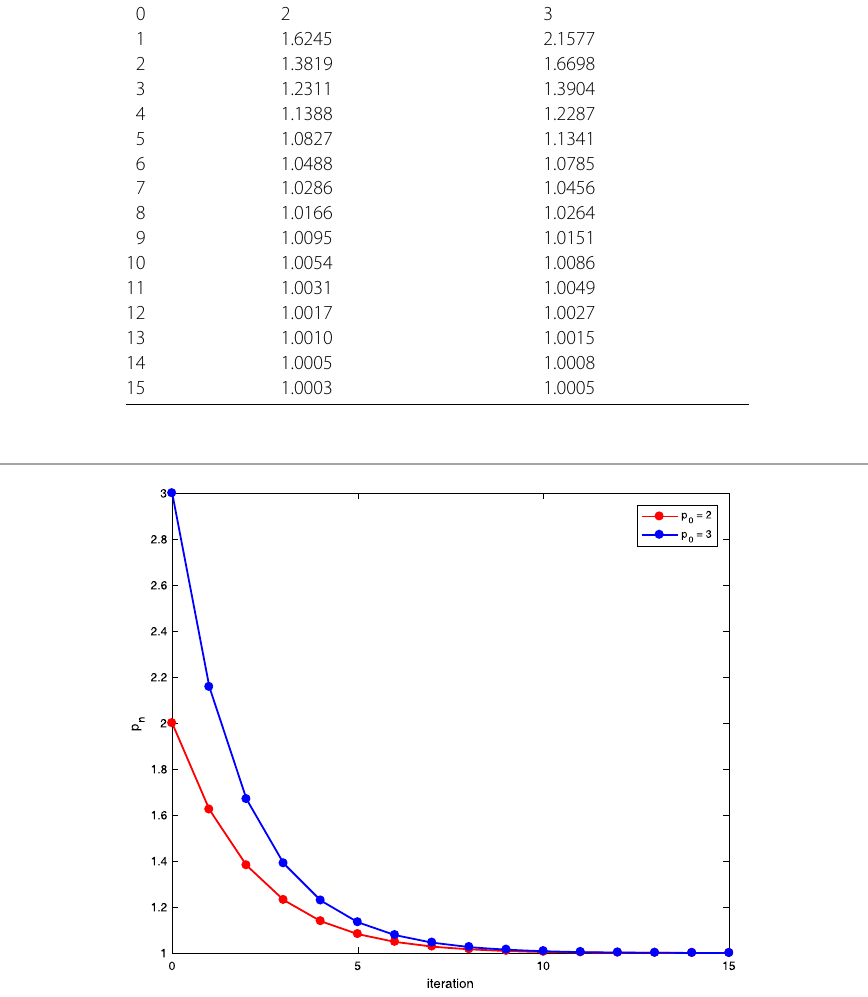
Table 1 Numerical results of Mann-type splitting method Iteration No.